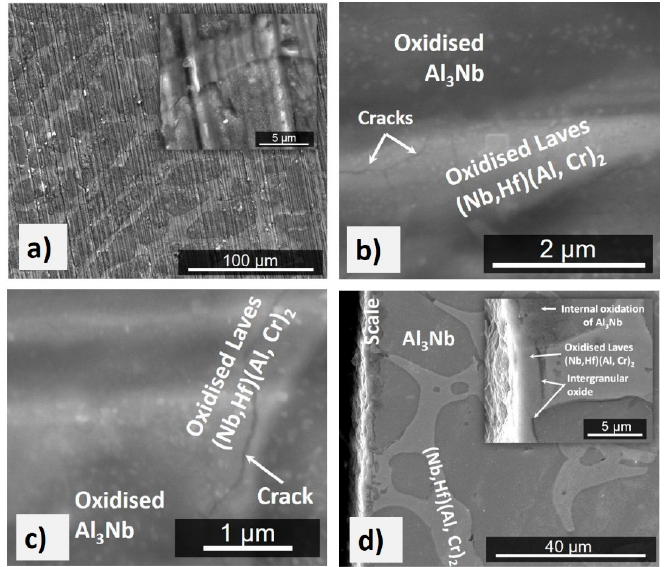
Figure 6. Secondary electron (SE) images of the scale formed on the alloy OHC3 after isothermal oxidation in air at 800 ◦ C for 100 h, ( a ) to ( c ) taken for the oxide surface, ( a ) X1000, ( b ) X70000, ( c ) X 60000, and ( d ) cross-section image, X3000. ( a ) Shows the polishing scratches (parallel “lines”) on the specimen surface that resulted from specimen preparation prior to oxidation.